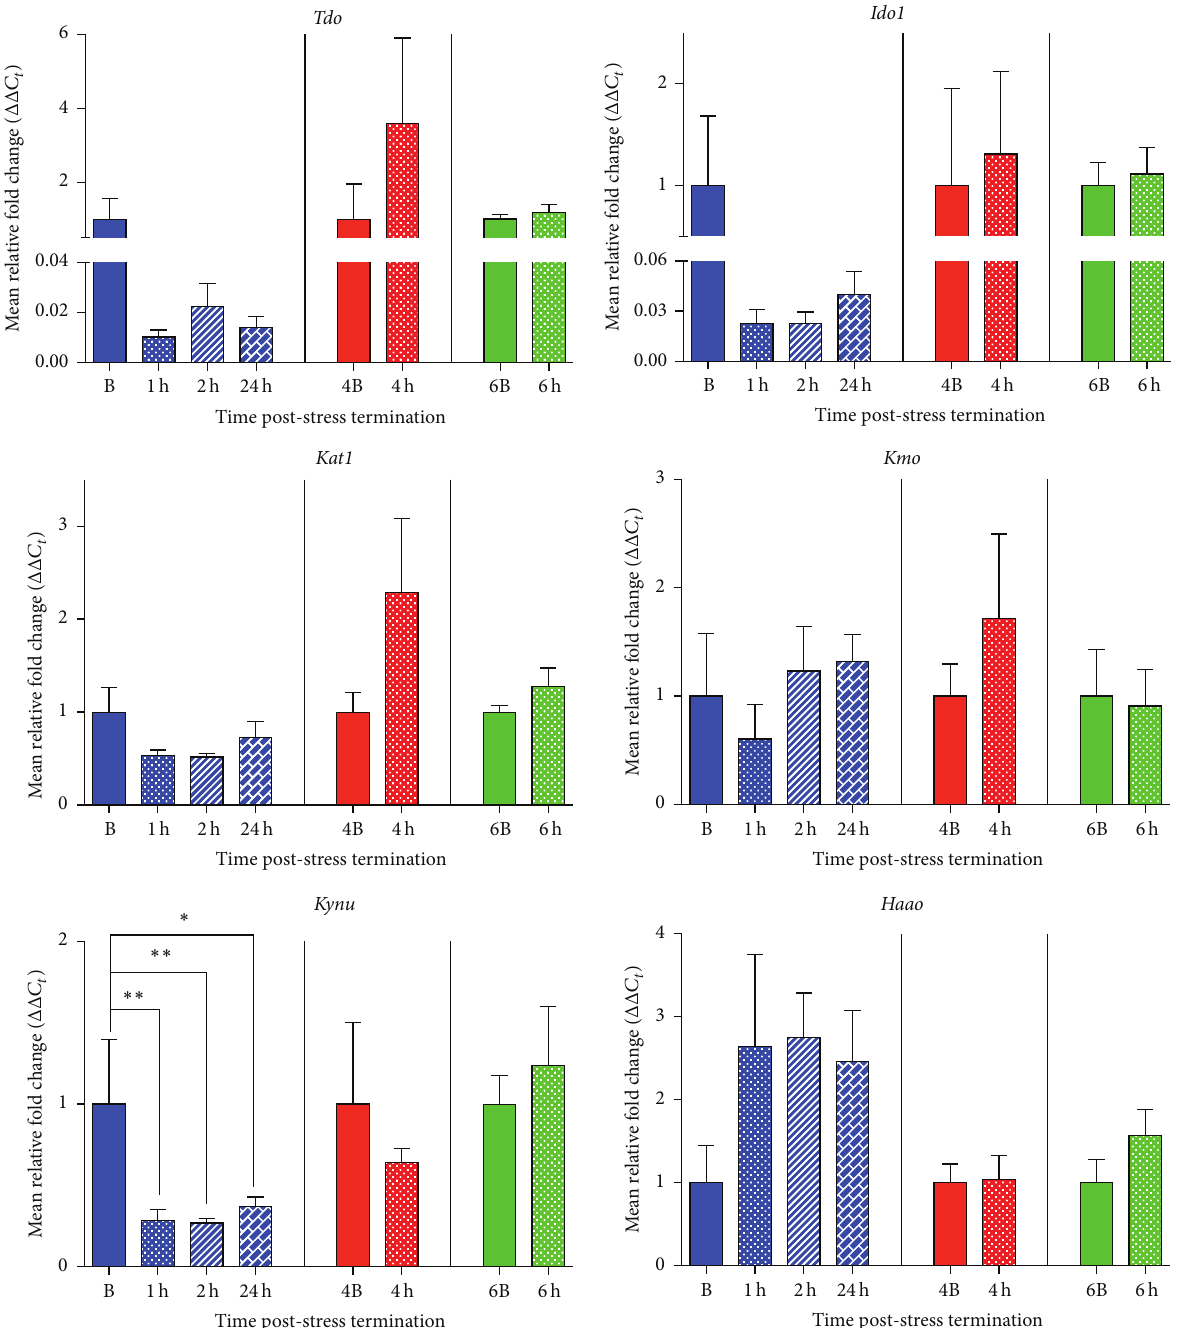
Figure 5: Effects of acute restraint stress on enzymes regulating the kynurenine pathway in the medial prefrontal cortex. mRNA expressionlevelsoftryptophan2,3-dioxygenase( Tdo ),indoleamine2,3-dioxygenase1( Ido1 ),kynurenineaminotransferase( Kat1 ),kynurenine 3-monooxygenase ( Kmo ), kynureninase ( Kynu ), and 3-hydroxyanthranilate 3,4-dioxygenase ( Haao ) were examined 1–24 h post-stress termination. All data are represented as means ± SEM (𝑛 = 3 – 6/ group ) . ∗ 𝑝 < 0.05 (in comparison to the B group); ∗∗ 𝑝 < 0.01 (compared to 3B